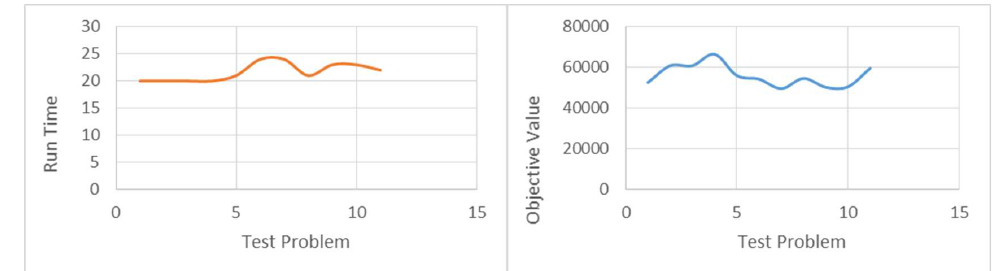
Fig. 13. Objective value and run time for scenario 4